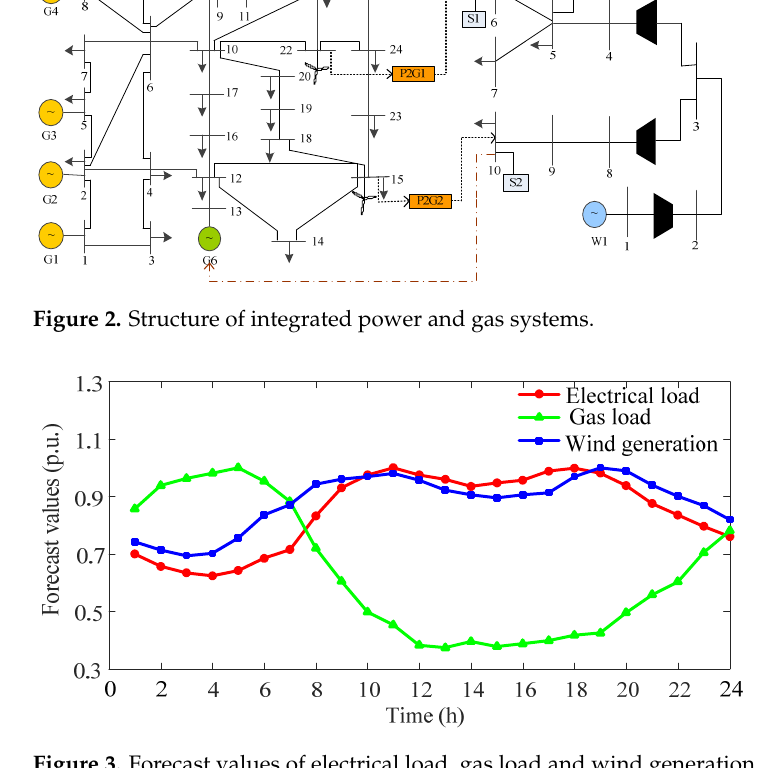
Figure 3. Forecast values of electrical load, gas load and wind generation.